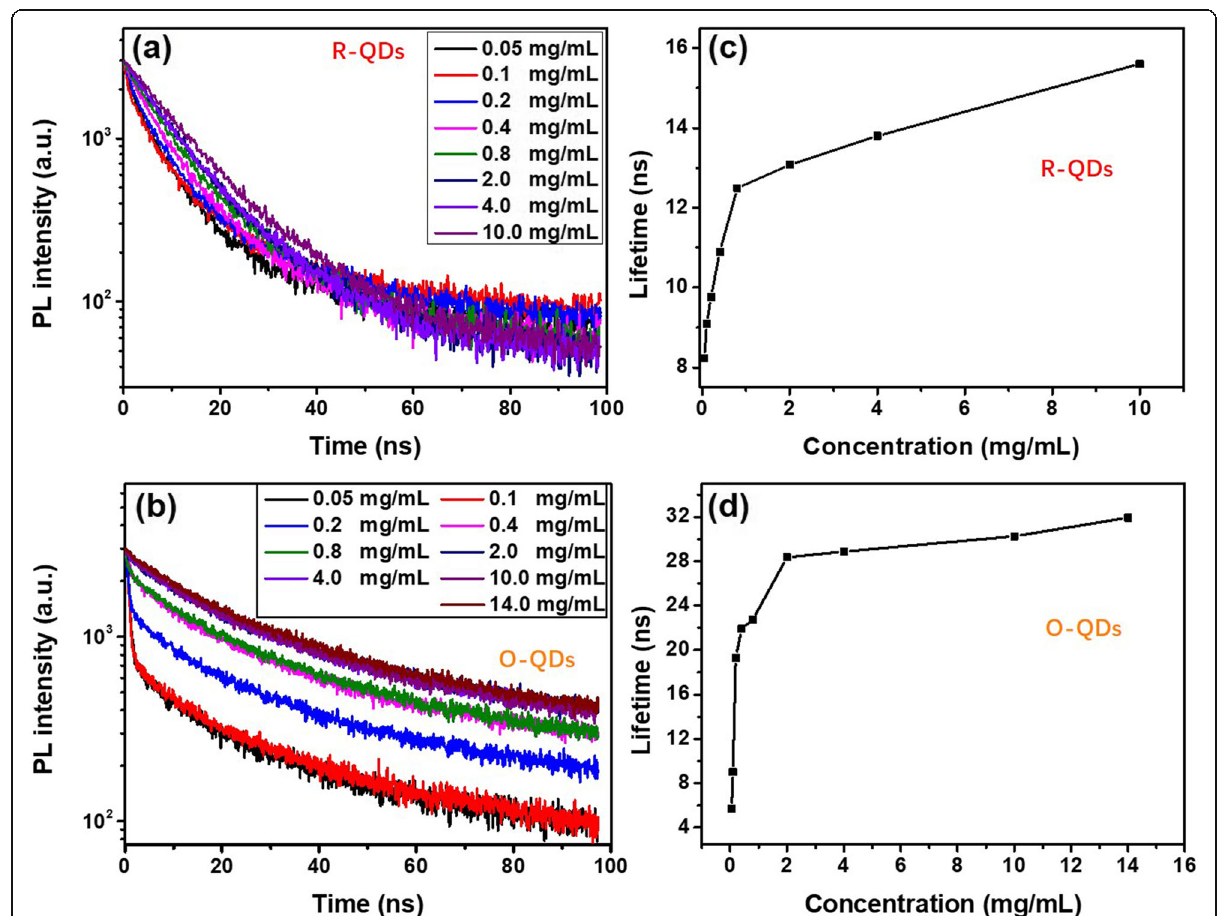
Fig. 3 TRPL decay curves of R-QD ( a ) and O-QD ( b )-based thin films. Lifetimes of R-QD ( c ) and O-QD ( d )-based silicone gel thin films with different